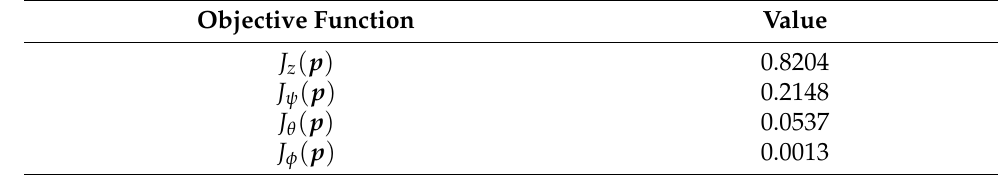
Table 3. Objective function values.